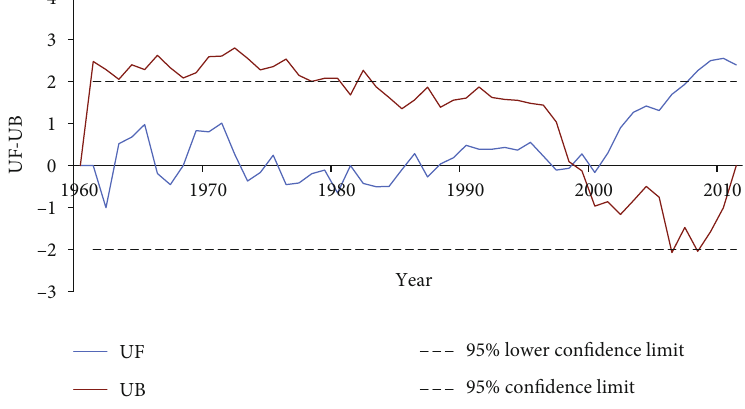
Figure 4: The M-K diagnosis of complete adjustment coe ffi